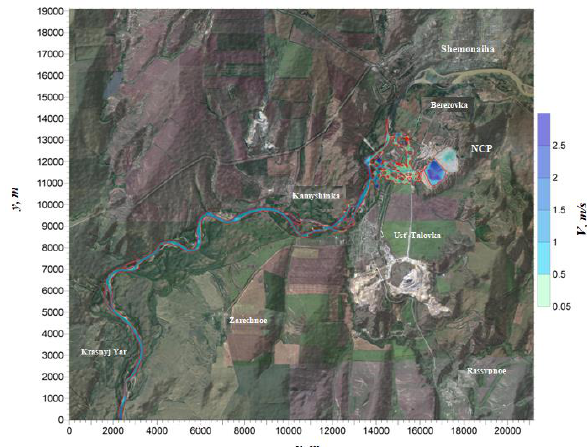
3.2 m/s and 8.1 m, respectively. The level of the